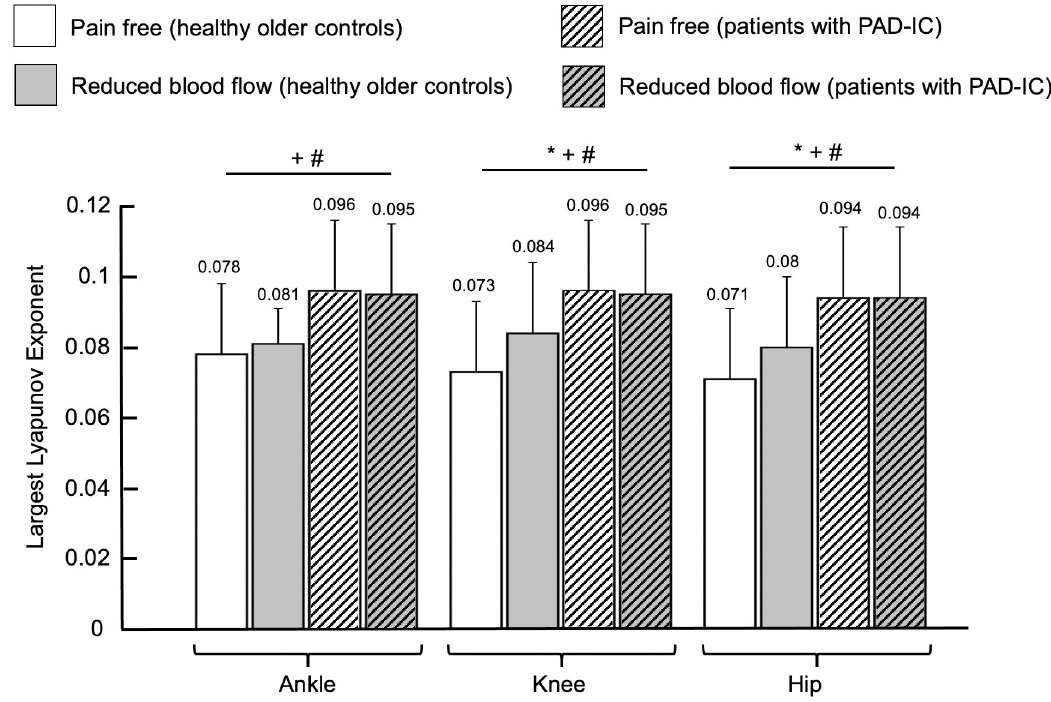
Fig 3. Largest Lyapunov exponent values for healthy older controls and for patients with Peripheral Artery Disease wth Intermittent Claudication (PAD-IC) in the pain free and reduced blood flow conditions for ankle, knee, and hip ranges of motion. � indicates significant differences between conditions (pain free vs. reduced blood flow, p < 0.05). + indicates significant differences between groups (healthy older controls vs. PAD-IC, p < 0.05). # indicates post-hoc tests where significant interaction exists between groups and conditions. Bar graphs represent the mean values and error bars represent the standard deviation. Mean value for each bar was mentioned at the top of the corresponding error bar.